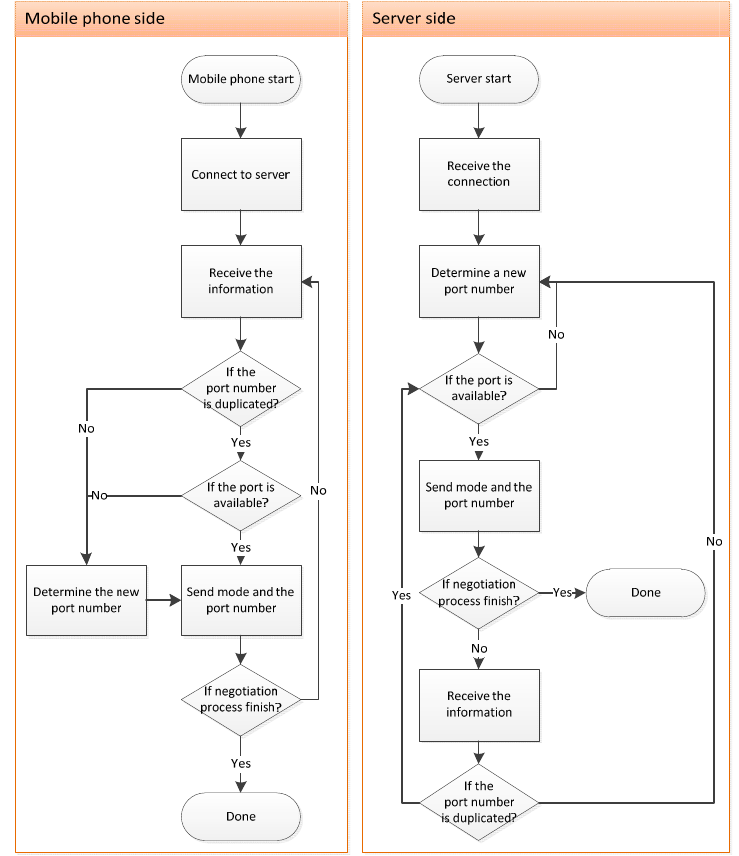
Figure 5. Smartphone- and server-based port negotiation processes.